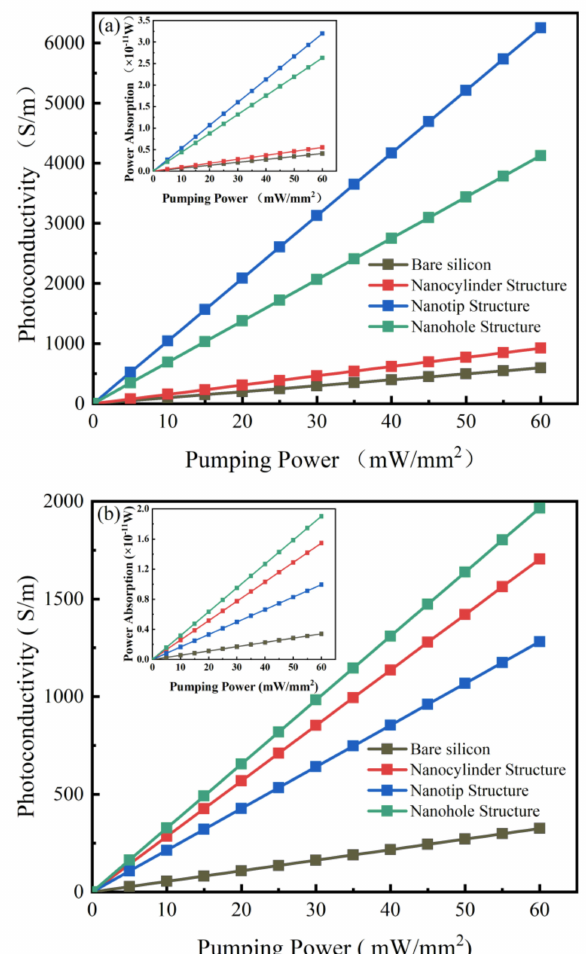
Figure 3. The power absorption (inset) and photoconductivity values of the bare silicon, nanocylinder, nanotip, and nanohole structures versus pumping power densities with a ( a ) 808 and ( b ) 532 nm pump beams,